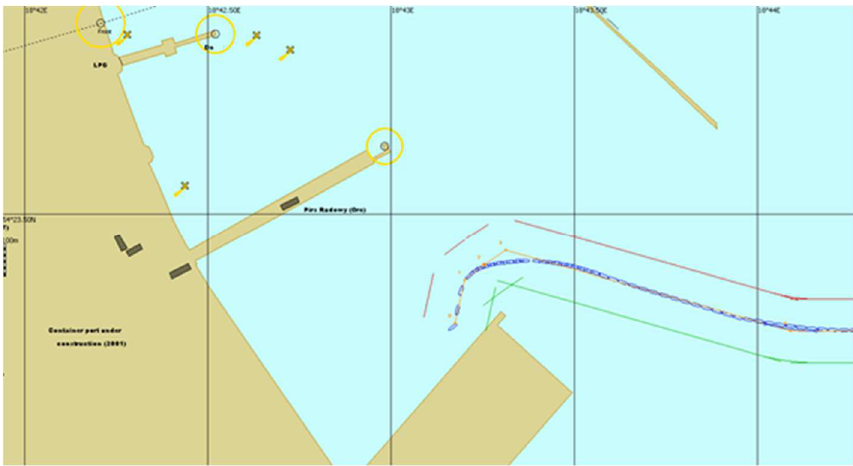
Figure 6. The trajectory recorded during the conduction of simulation attempt through the planned route from the first task. Source: Navi-Trainer Professional 5000.